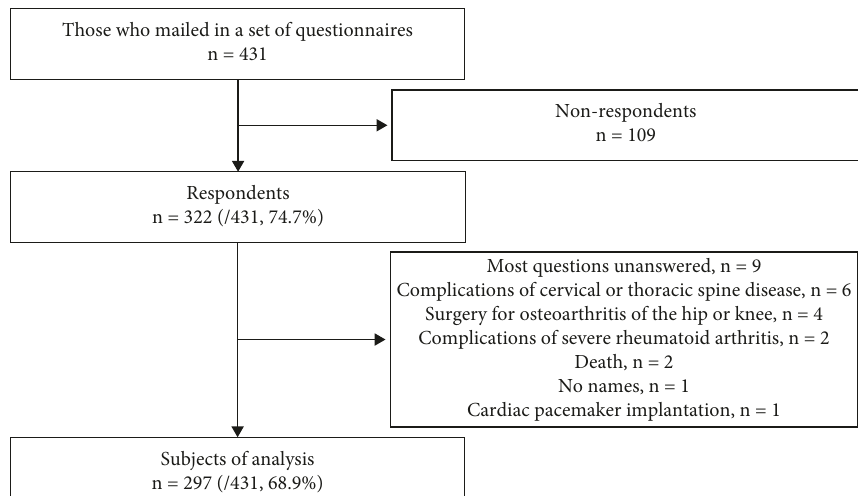
Figure 2: Flowchart of extracting participants for analysis. A total of 431 older adults who had undergone surgery for lumbar spinal stenosis were included in the study and 322 responded (74.7%). Ultimately, data from 297 individuals (68.9%) were